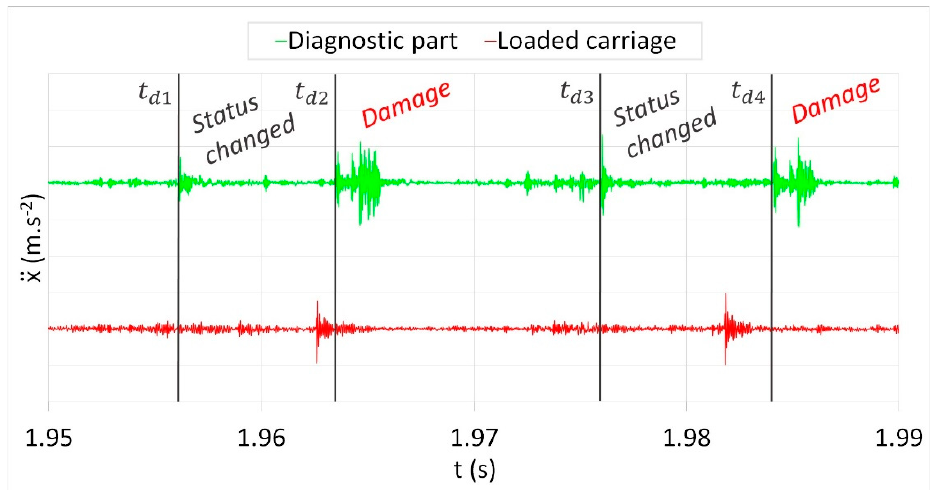
d 42 ) and minor ( T d 31 ) acceleration amplitudes may be detected with the parameters that are specified in Table 9. Table 9. Time periods and their parameters according to Figure 24.